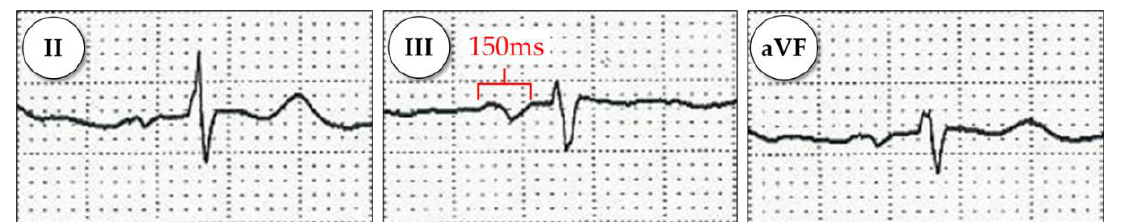
Figure A1. Advanced interatrial block. P-wave duration more than 120 ms along with biphasic P-wave in inferior leads II, III and aVF.